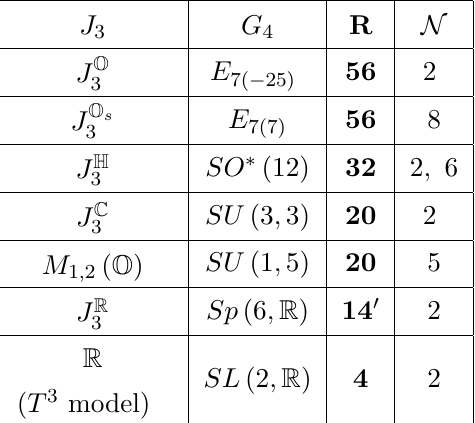
Table 1 . Simple, non-degenerate duality groups = G 4 in d = 4 related to FTS M ( J 3 ) on simple G rank-3 Jordan algebras J 3 with symplectic irreducible representations. R . Here O , H , C and R respectively denote the four division algebras of octonions, quaternions, complex and real numbers, and O s , H s , C s are the corresponding split forms. The G 4 related to split forms O s , H s , C s is the maximally non-compact ( split ) real form of the corresponding compact Lie group. J H is related to 3 both 8 and 24 supersymmetries, because the corresponding supergravity theories are \twins" , they share the same bosonic